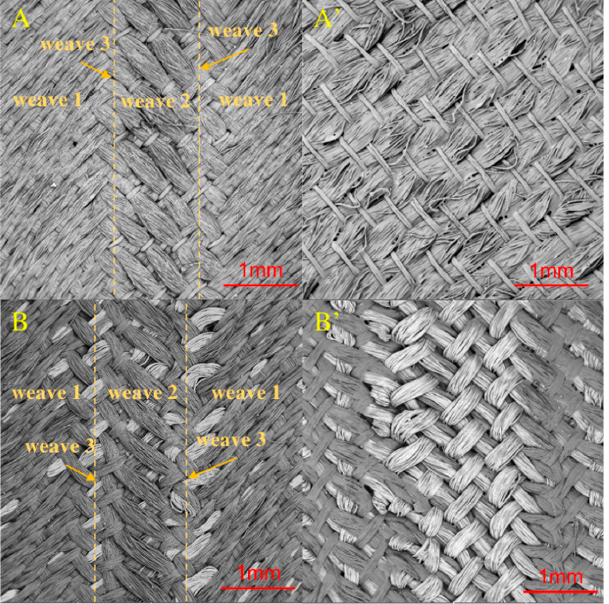
Figure 4. Morphology of the two Song Brocade fabrics from SEM (( A , A’ ): the front side and back side of sample S1; ( B , B’ ): the front side and back side of sample S2).